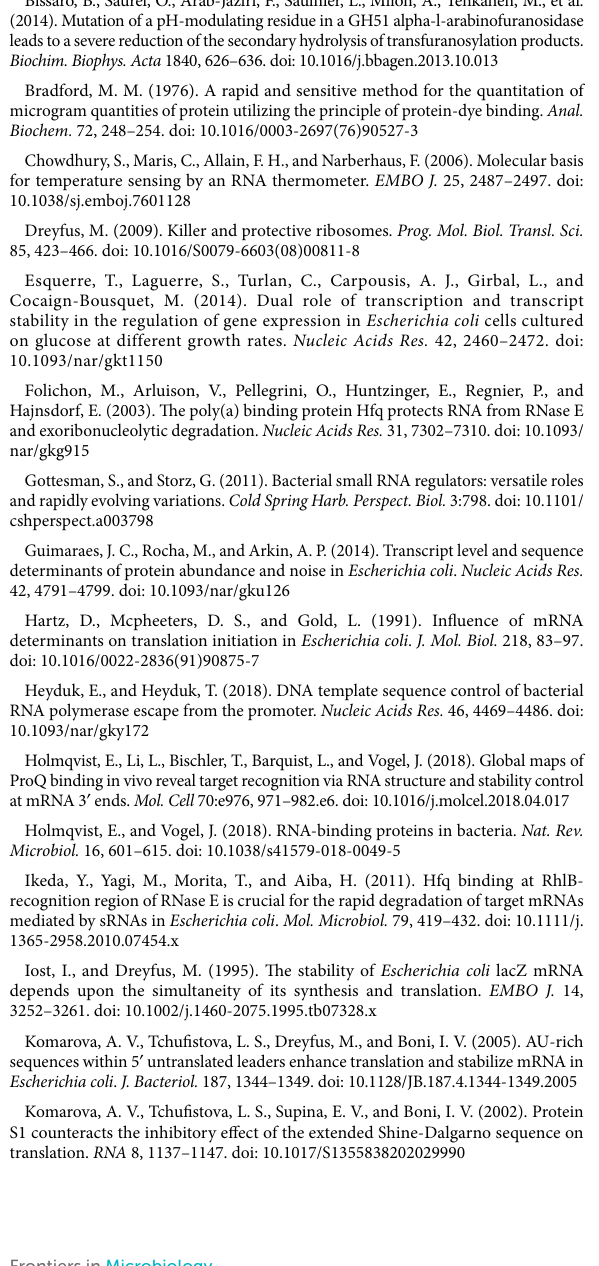
SUPPLEMENTARY FIGURE S1 Correlations between protein and mRNA levels of reporter genes fused to the eight selected 5’UTRs (A) for lacZ , R 2 = 0.91 ; (B) for txAbF , R 2 = 0.93; and (C) for msfGFP , R 2 = 0.87 The eight selected constructs were 5’UTR_500_07, 5’UTR_1,500_14, 5’UTR_500_09, 5’UTR_1,500_15, 5’UTR_2,500_16, 5’UTR_33k_28, 5’UTR_33K_30 and 5’UTR_66k_35. The black lines are linear regression fits. Error bars represent standard deviations ( n = 9 biological triplicates and technical triplicates for measurements of β -galactosidase and α -L-arabinofuranosidase activity and msfGFP fluorescence/OD, and n = 3 for measurements of mRNA